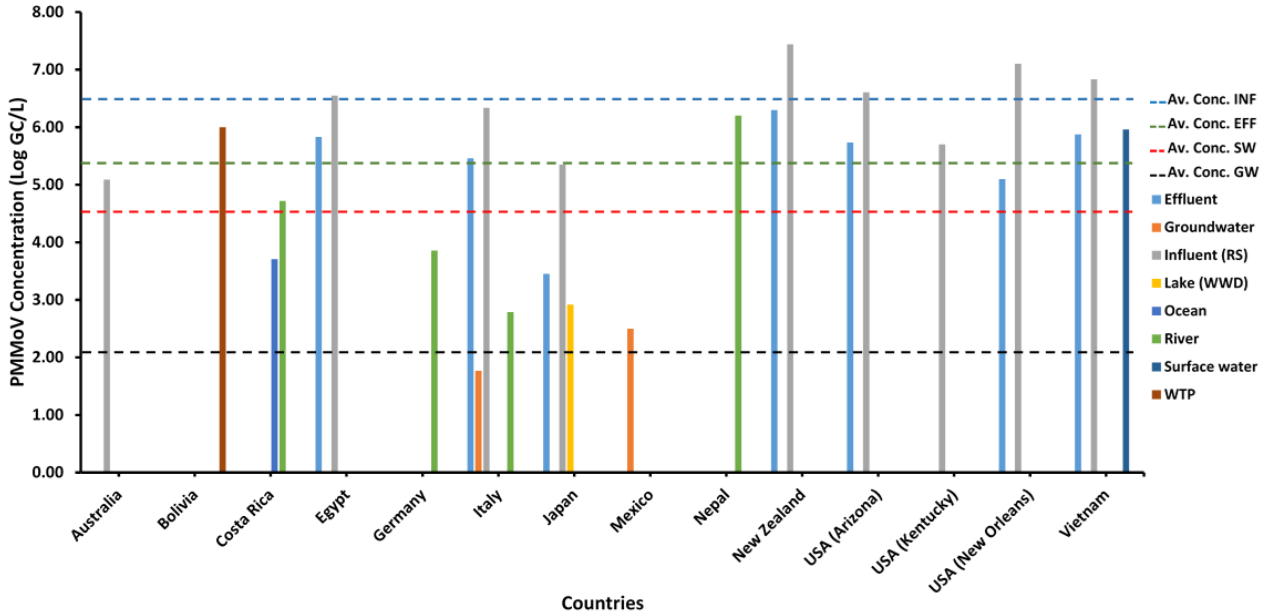
Figure 5. PMMoV concentration in different water environments [136,145,150,152,154,157,161,175,177,184,186,187,192–194]. WTP: wastewater treatment pond, Av. Conc. INF denotes average concentration of PMMoV in wastewater influents (including raw sewage (RS) and untreated wastewater) expressed in log genome copies (GC)/L, EFF: wastewater effluents, SW: surface water, GW: groundwater.